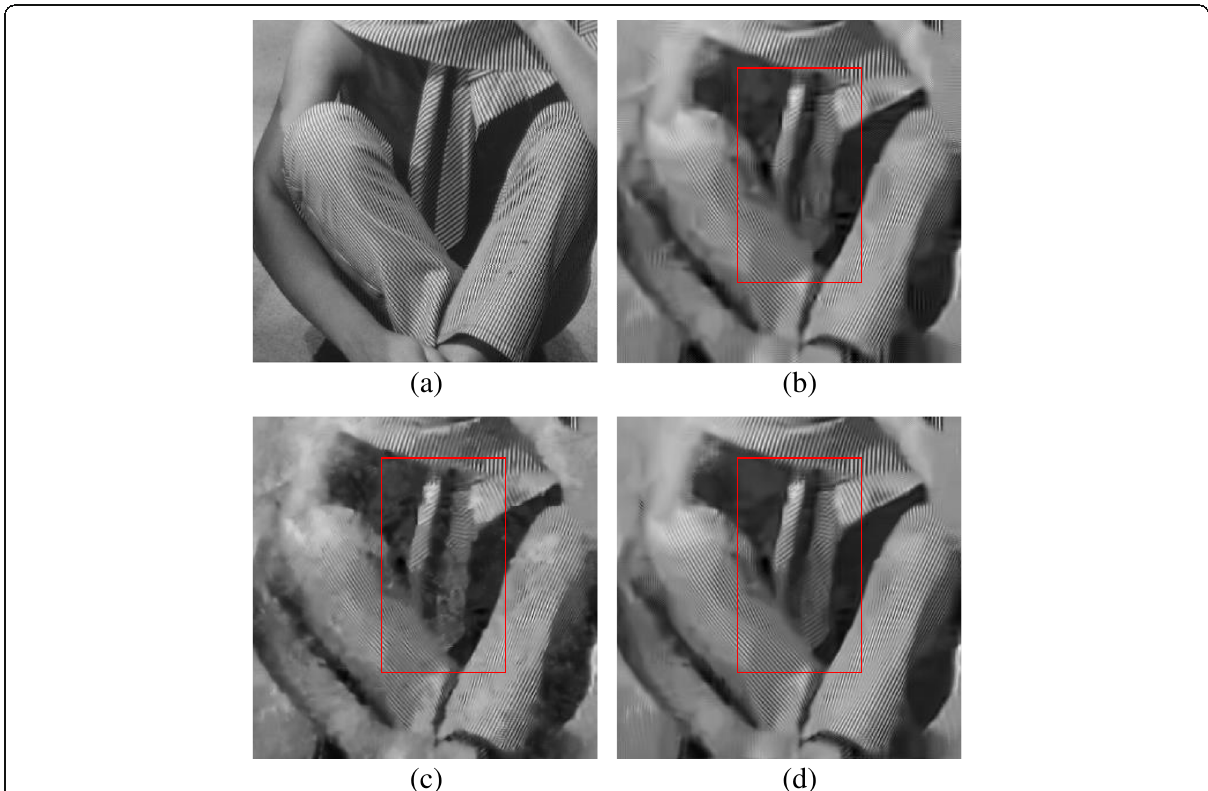
Fig. 6 Comparison of denoised results by b BM3D, c BM3D-SAPCA, and d SA-BM1-3D, for the case of adding noise ( σ = 100) on the original image shown in